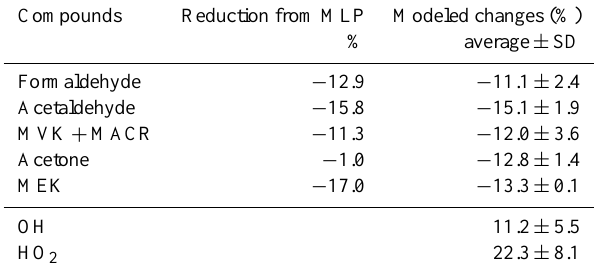
Table 5. The average of relative changes in OVOC concentrations from the scenario without pollution control measures (M5) to the control period (M4), compared to the corresponding values from the MLP network. Modelled change (%) = (M4–M5)/M5 ×